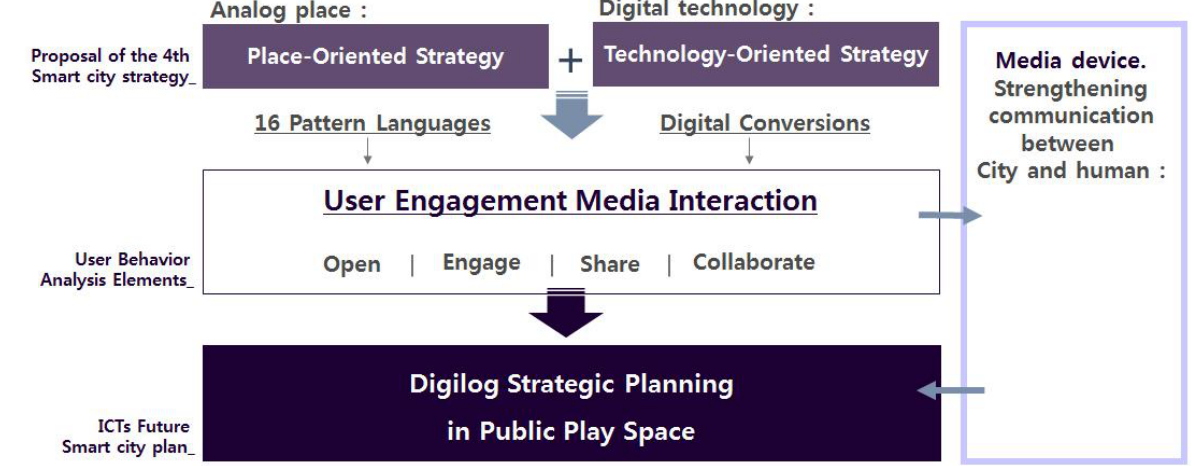
Figure 3. The ICTs ’ future smart city planning presents a digilog strategic plan.